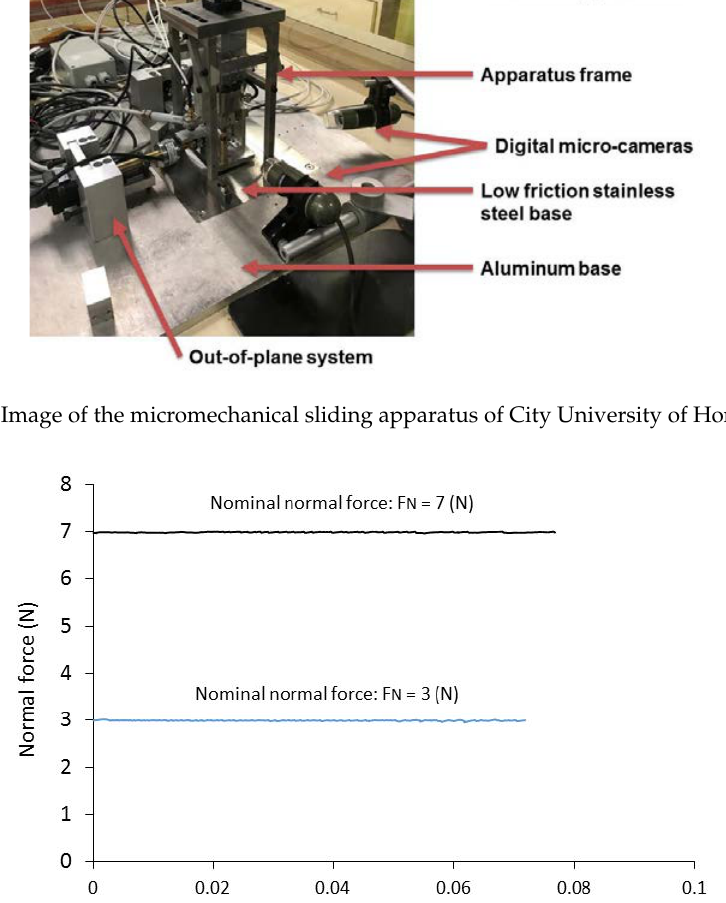
Figure 3. Image of the micromechanical sliding apparatus of City University of Hong Kong.